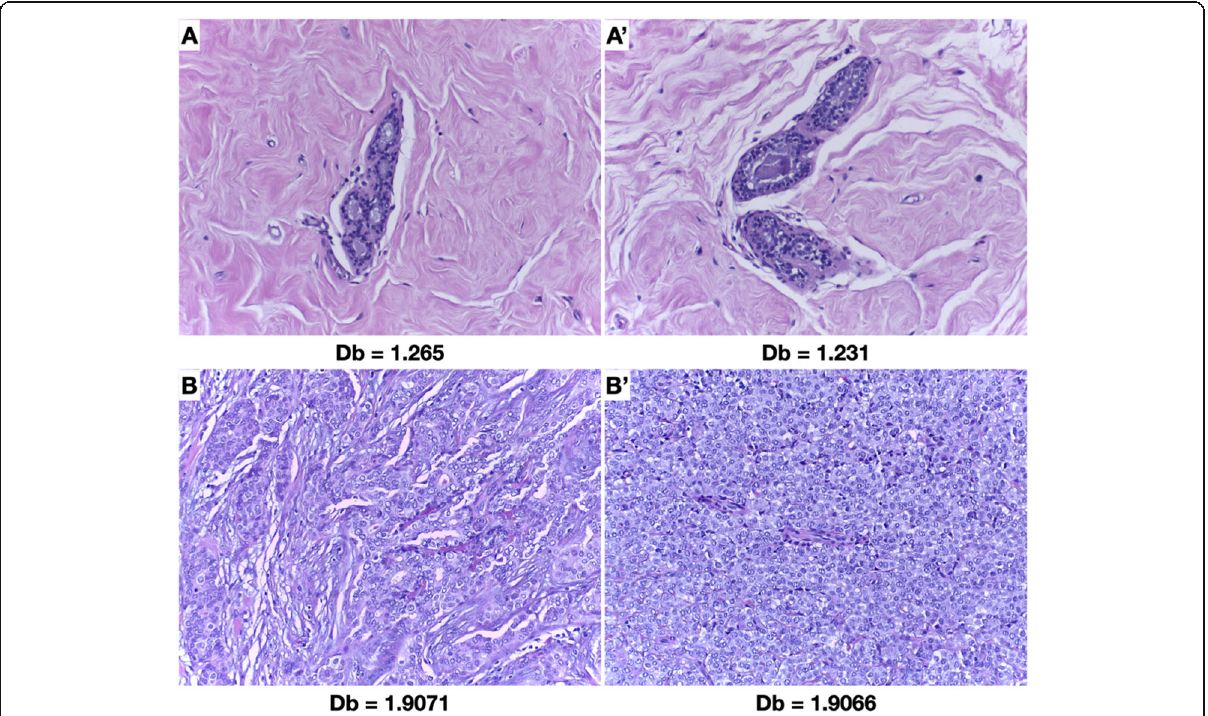
Fig. 3 Representative comparison of Db obtained from images produced from the BACH set. A and A ’ : normal breast tissue; B and B ′ : invasive breast